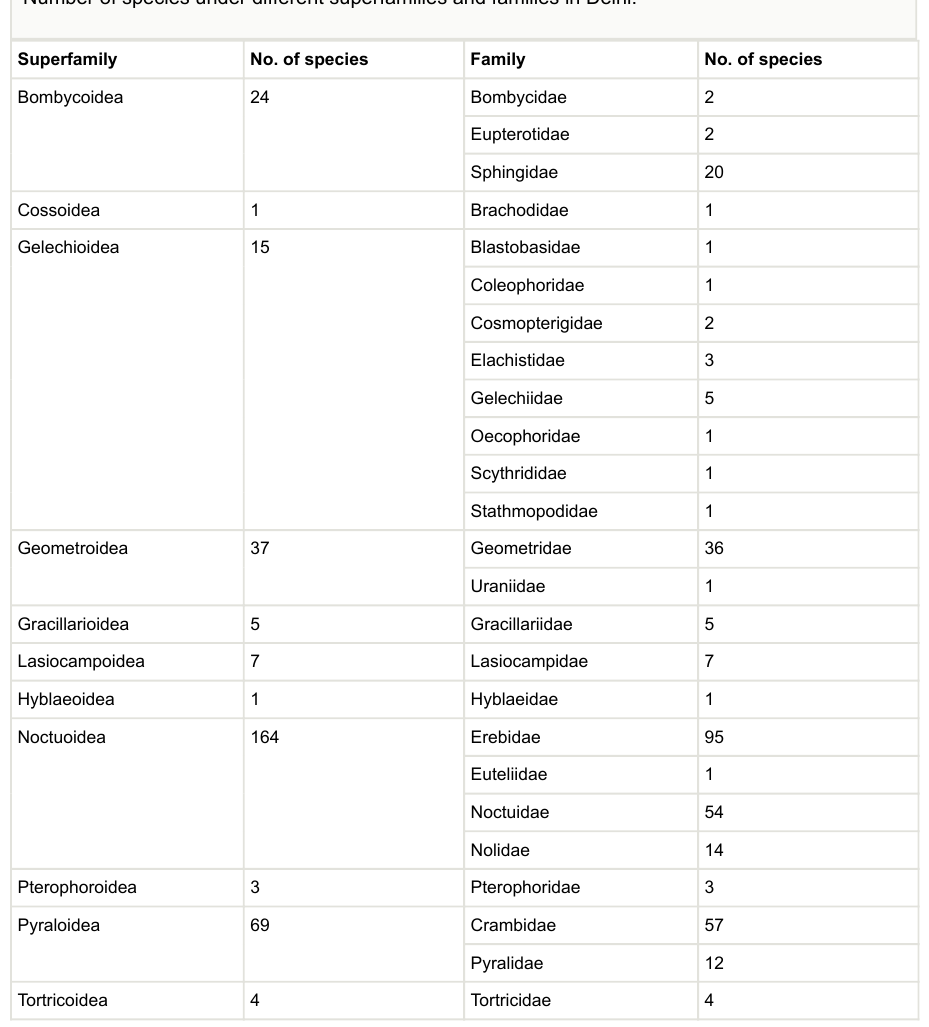
Table 1. Number of species under different superfamilies and families in